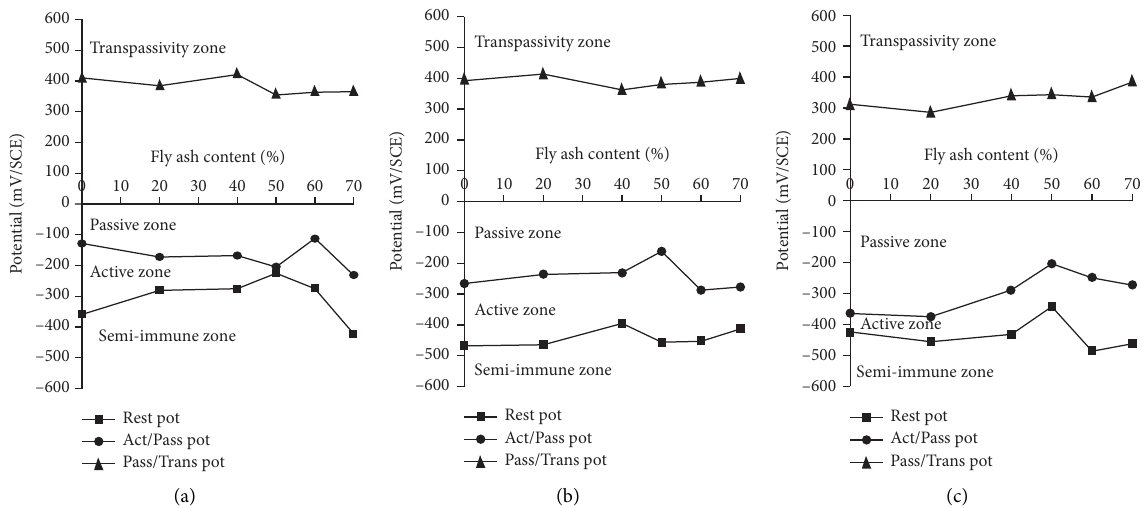
Figure 6: Potential versus different fly-ash content for w/b ratio of 0.40. (a) CRS. (b) Tata TMT. (c) Local TMT.